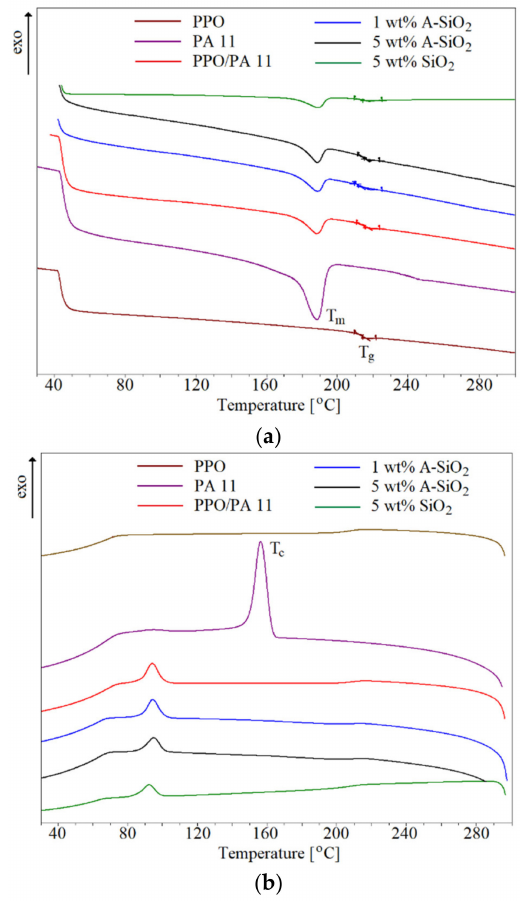
Figure 9. DSC curves of PPO, PA11, and PPO/PA11/silica composites: ( a ) second heating and ( b )